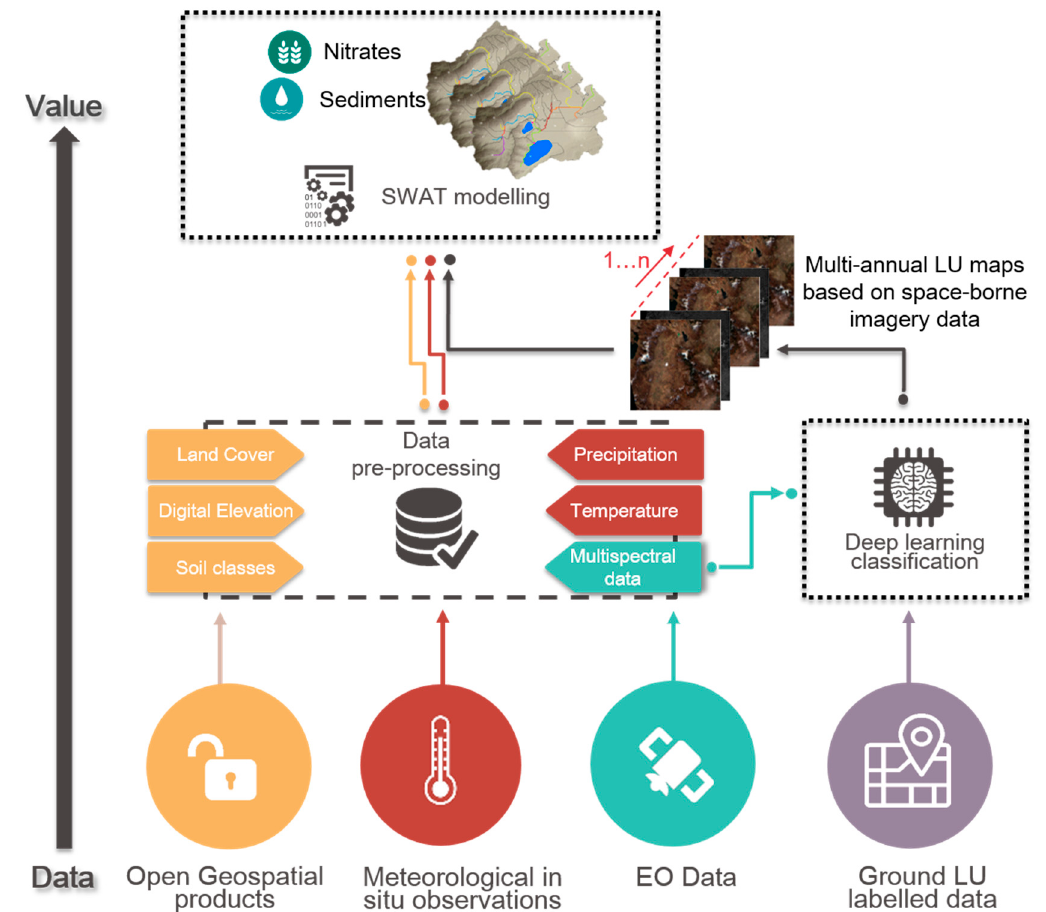
Figure 1. Workflow of the proposed hybrid approach. A set of satellite imagery data is fed into a deep learning (DL) algorithm. The land use (LU) maps produced by the DL algorithm are used separately to feed the soil and water assessment tool (SWAT) model.